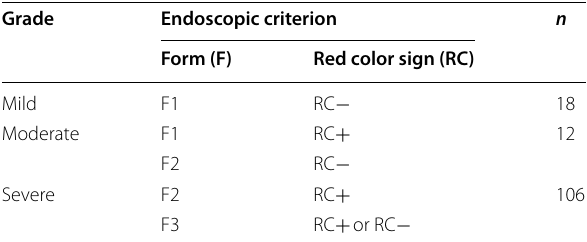
standard deviation, *: the estimated risk of patients’ characteristics with univariable analysis ± Table 2 The grading system for esophageal varices and endoscopic results of our